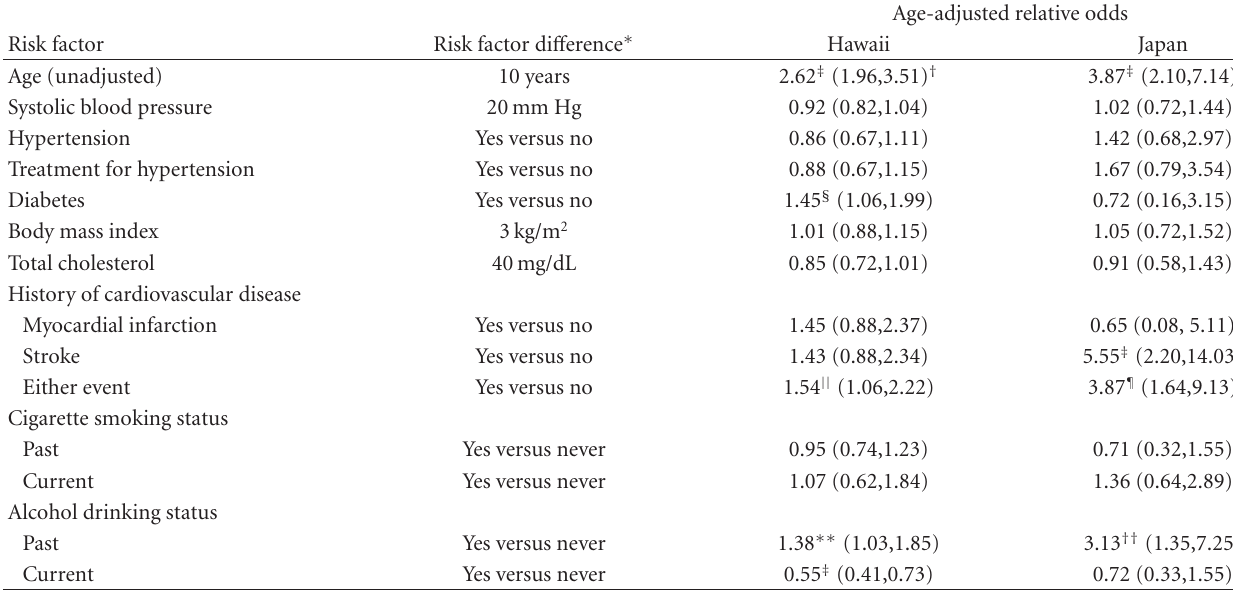
Table 3: Age-adjusted relative odds of having ≥ 1 impairment in activities of daily living (ADL) according to risk factor di ff erences in elderly japanese men in Hawaii and Japan.